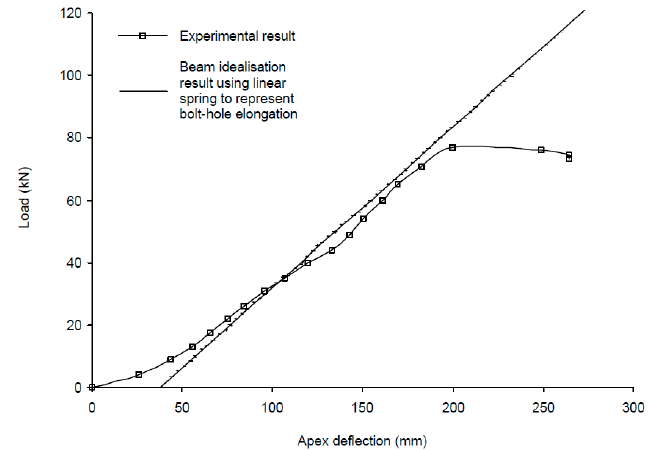
Figure 7. Variation of vertical load against apex deflection [3].